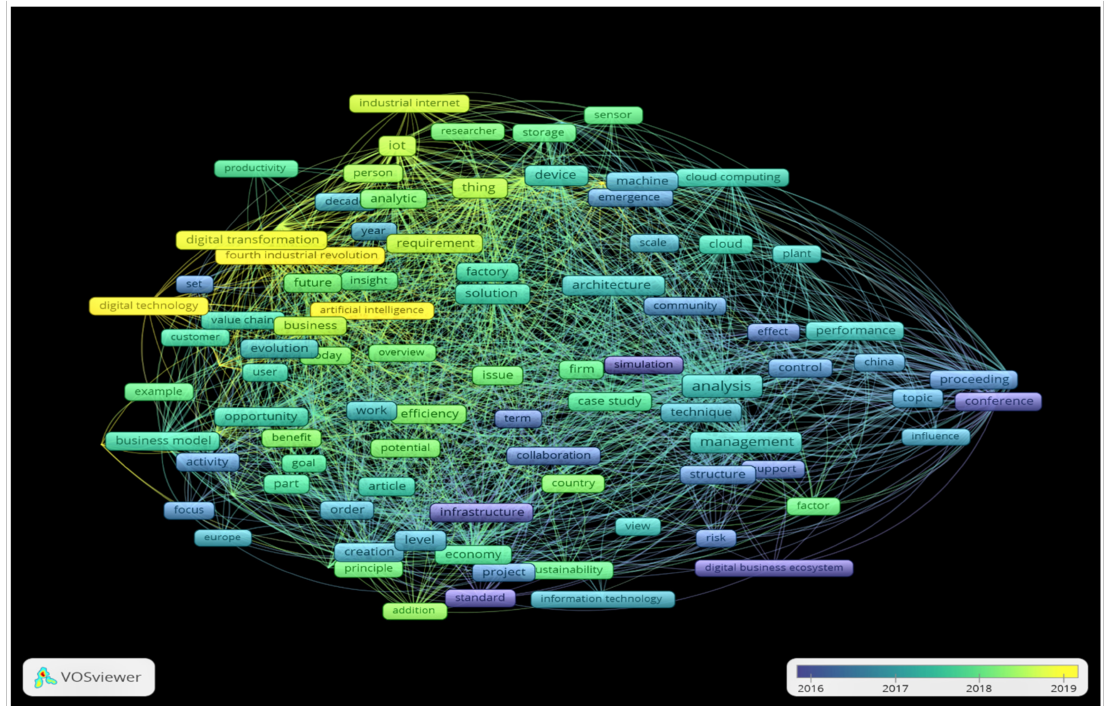
Figure 5. The classification of literature using the